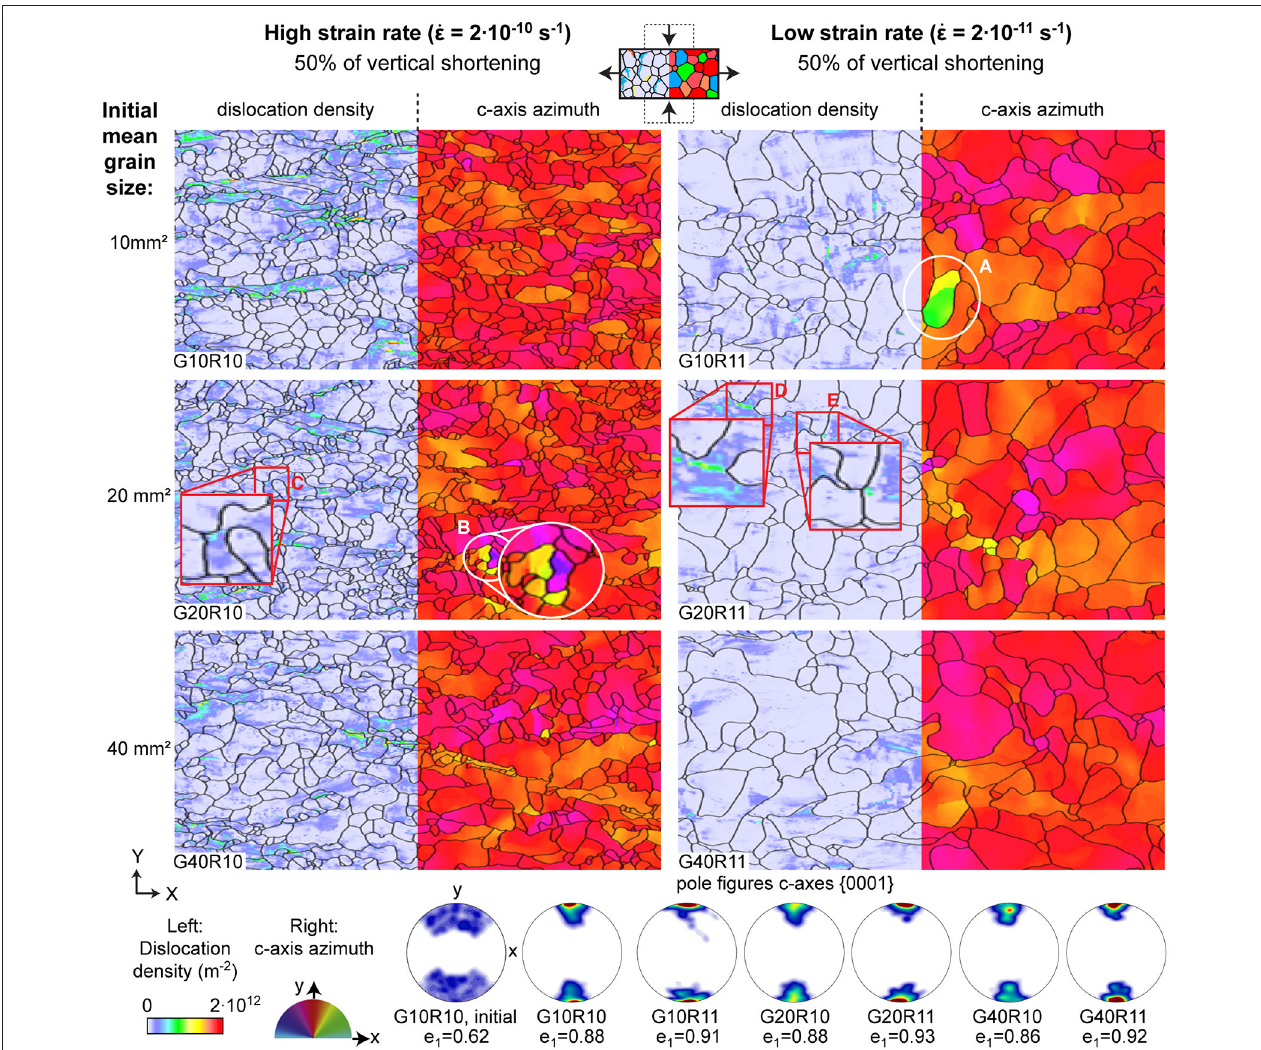
FIGURE 3 | Overview of numerical microstructures after 50% of vertical shortening (i.e., final simulation step) with grain boundary networks (black lines) for the whole deformation box. The box is subdivided in the color code for dislocation density (left) and for the c-axes azimuths (right) , where red colors indicate vertically oriented c-axes. The corresponding pole figures and first eigenvalues of the second order orientation tensor (e 1 ) are shown below. The initial pole figure and first eigenvalue of G10R10 are provided as an example of the starting configuration. The squares indicate regions where grain dissection has either occurred or is most likely imminent, while the circles show subgrain boundaries likely to develop into new high-angle grain boundaries by polygonisation.